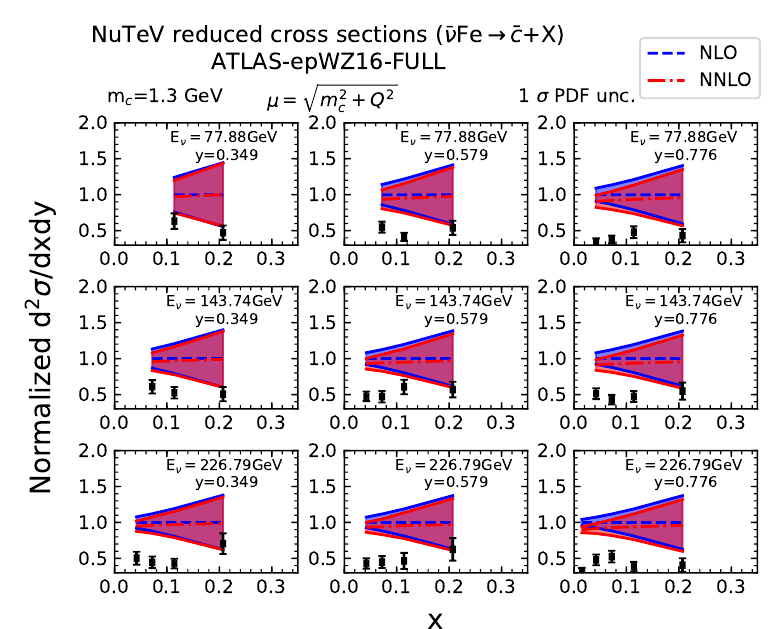
Figure 10 . Similar as (cid:12)gure 9 for charm anti-quark production using ATLAS-epWZ16 NNLO